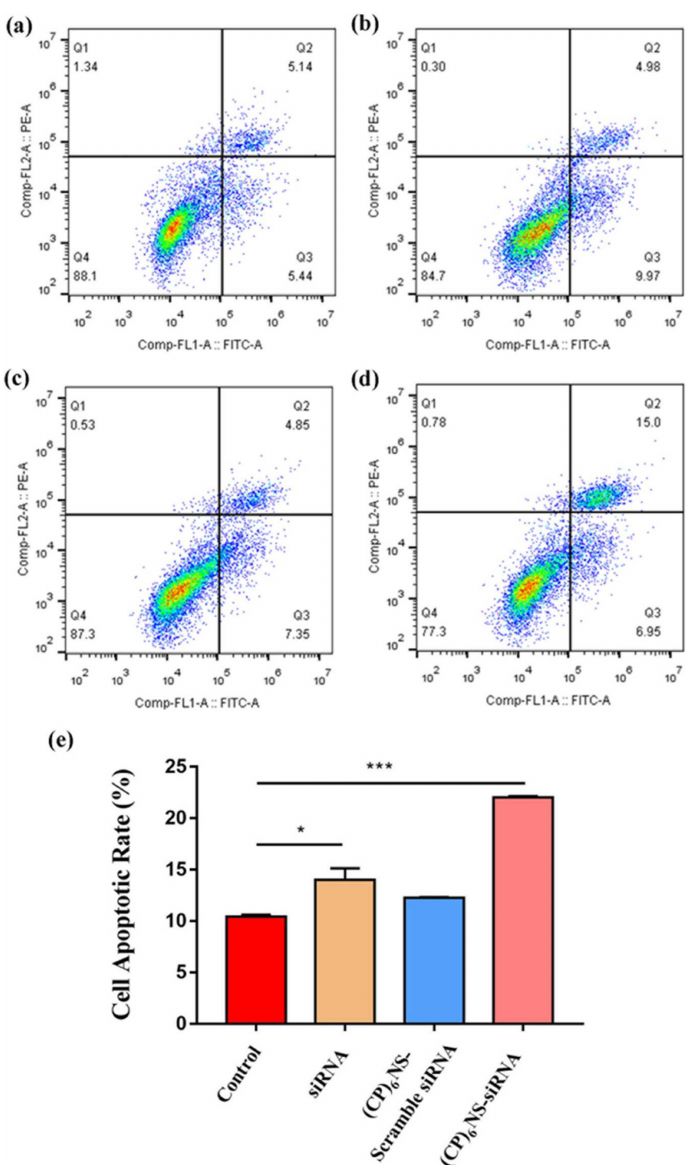
Figure 8. Flow cytometric analysis of cell apoptosis in each treatment group. ( a ) Control group, ( b ) free siRNA group, ( c ) (CP) 6 NS-scrambled siRNA treatment group and ( d ) (CP) 6 NS-survivin siRNA treatment group. ( e ) Statistical analysis of apoptosis rates. Each value is expressed as the mean ± SD ( n =